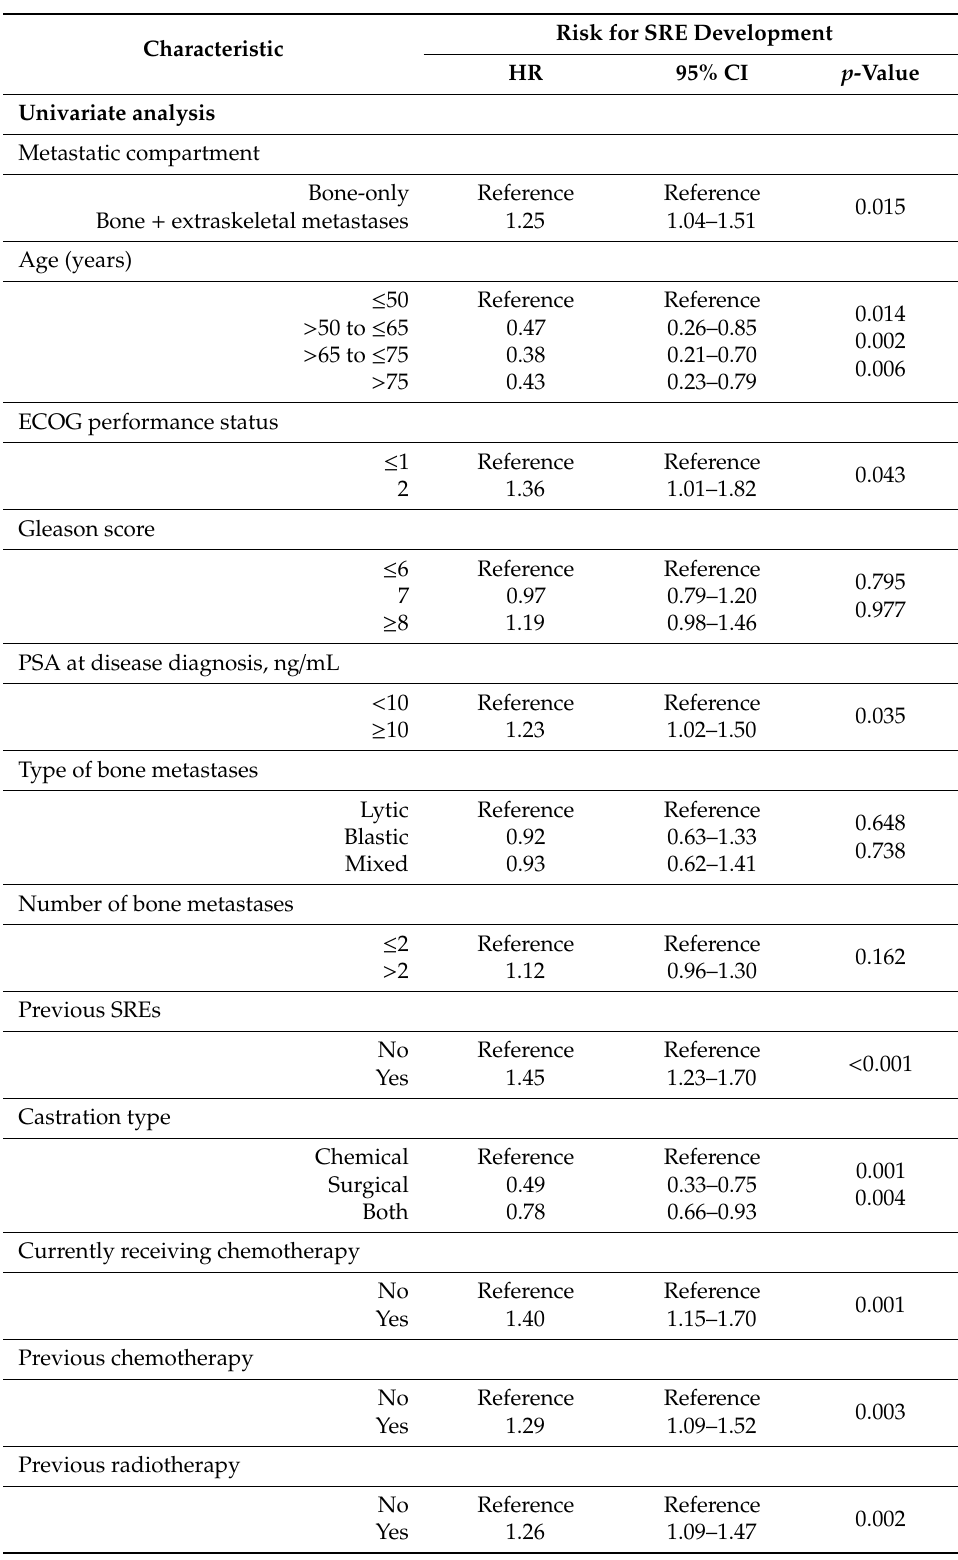
Table 3. Risk for development of first on-treatment